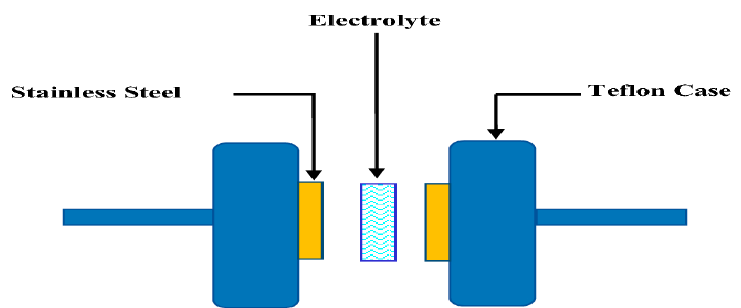
Figure 1. Schematic diagram of cell arrangement for TNM, LSV, and impedance study. Dielectric Constant